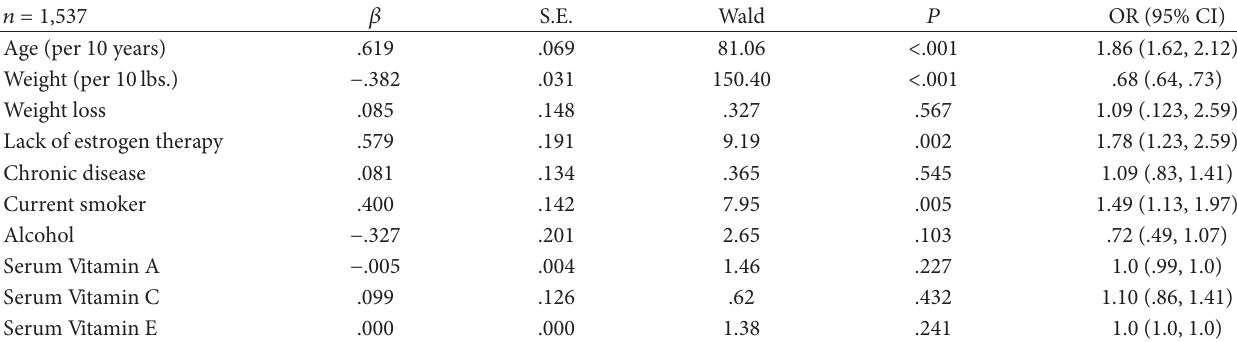
T 1: Full model logistic regression: white females, age